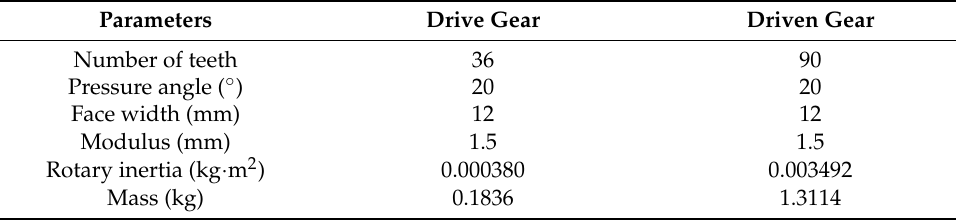
Table 1. Gear parameter. Parameters Drive Gear Driven Gear Number of teeth